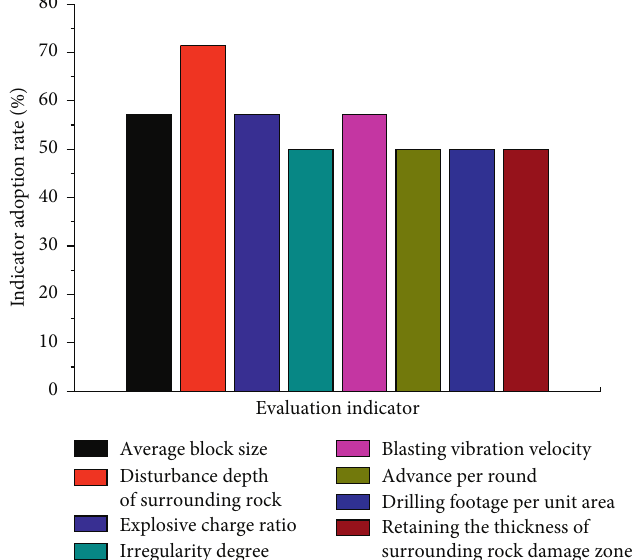
Figure 7: Relatively important quantitative indices (4 points).